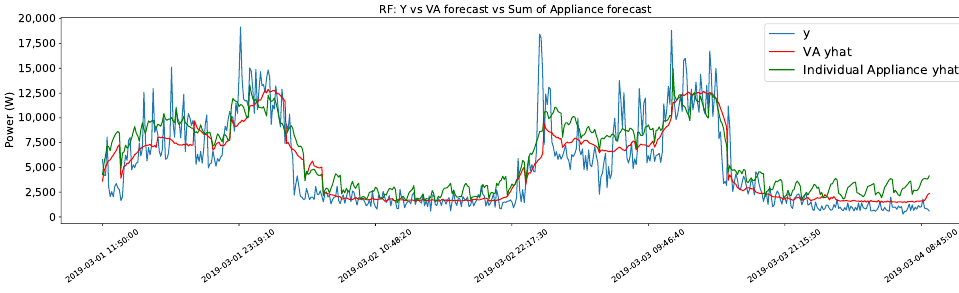
Figure 3. Virtual aggregate forecast against the sum of individual appliance forecasts.